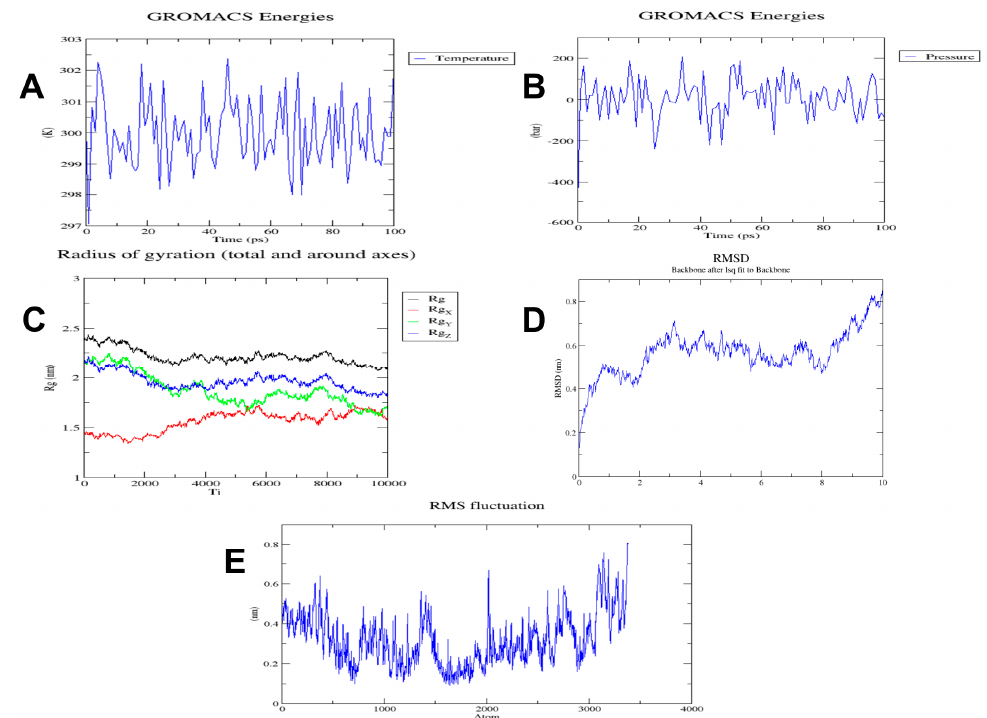
Figure 2. Graphs generated during di ff erent stages of MD simulations. ( A ) Temperature variations during simulation. System temperature reached 300 K and showed minimum fluctuations afterward during 100 ps; ( B ) pressure variations during simulation. Pressure plot shows that the average pressure is − 2.44361 bar during 100 ps; ( C ) radius of gyration plot. Analysis of radius of gyration vaccine construct is stable in its compact form during the simulation time; ( D ) RMSD plot of backbone. RMSD graph shows that RMSD of protein backbone reaches ~0.6 nm and is maintained mostly, which represents minimum structural deviations of vaccine construct; ( E ) RMSF (Root Mean Square Fluctuation) plot. RMSF plot of side chains shows the regions with high flexibility present in peaks.